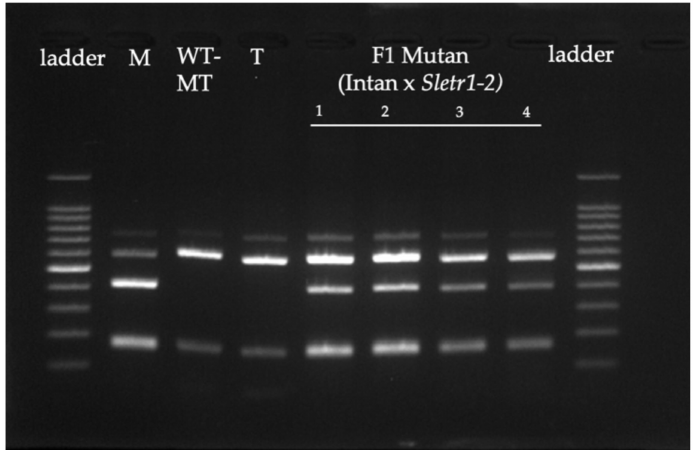
Figure 1. Genotyping of the Sletr1-2 mutant allele in F1 mutant plants by CAPs marker. Ladder (DNA ladder 100 bp); M (mutant Sletr1-2 ); WT-MT (wild type ‘Micro-Tom’); T (tropical tomato cultivar ‘Intan’); F1 mutant (F1 plants from ‘Intan’ × Sletr1-2 mutant). Genotyping of the Sletr1-2 other tropical tomato cultivars (‘Mirah’, ‘Ratna’, and ‘Mutiara’) produces the same picture